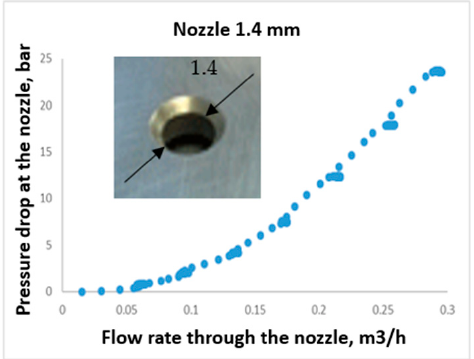
Figure A1. The example of the obtained hydrodynamic characteristics of the ICD.